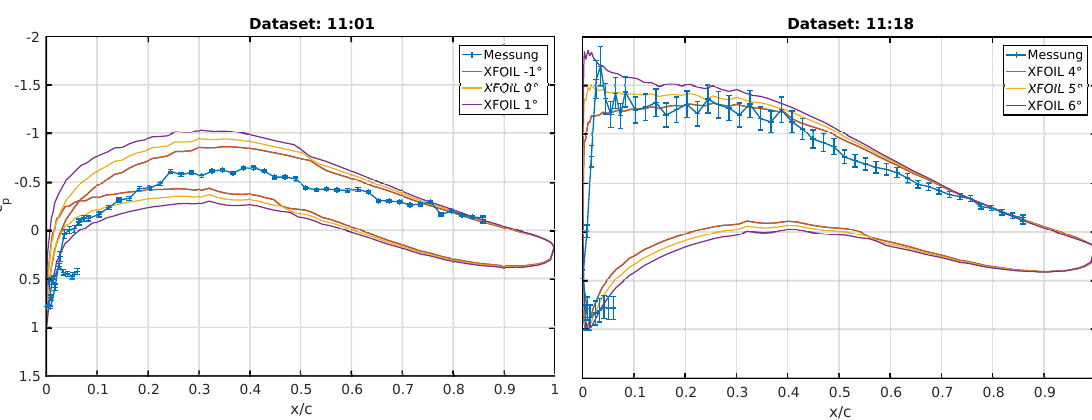
Figure 12. Pressure ( c p ) distribution on the glove. ( Left ) SU; ( Right )